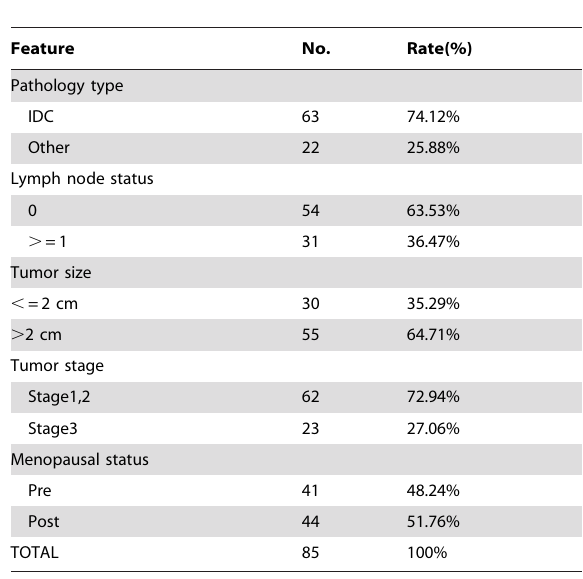
Table 1. Clinical and histopathological features in 85 triple negative